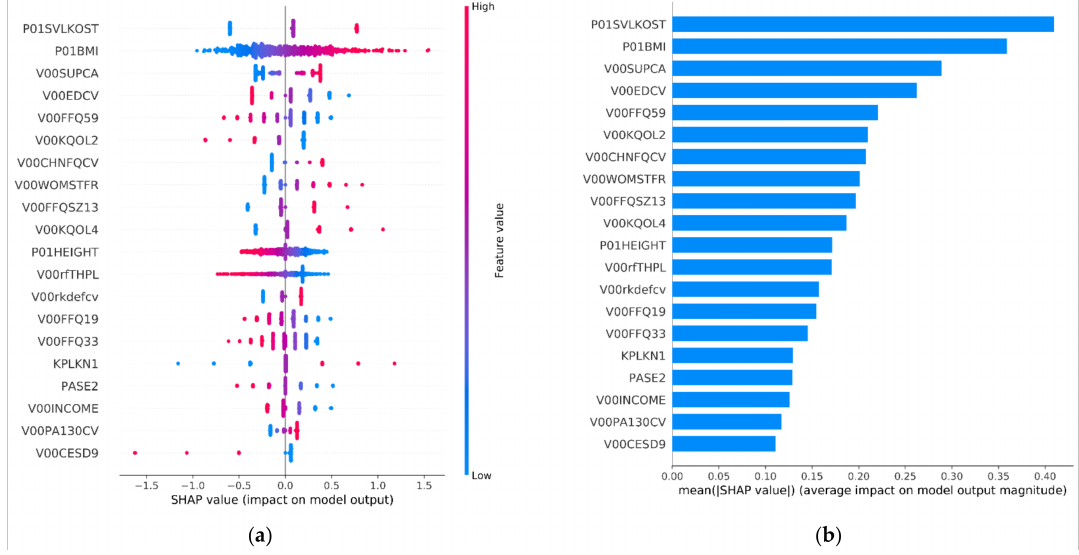
Figure 10. This figure depicts: ( a ) the SHAP summary plot and; ( b ) the SHAP feature importance for the SVM trained on the features selected by the proposed